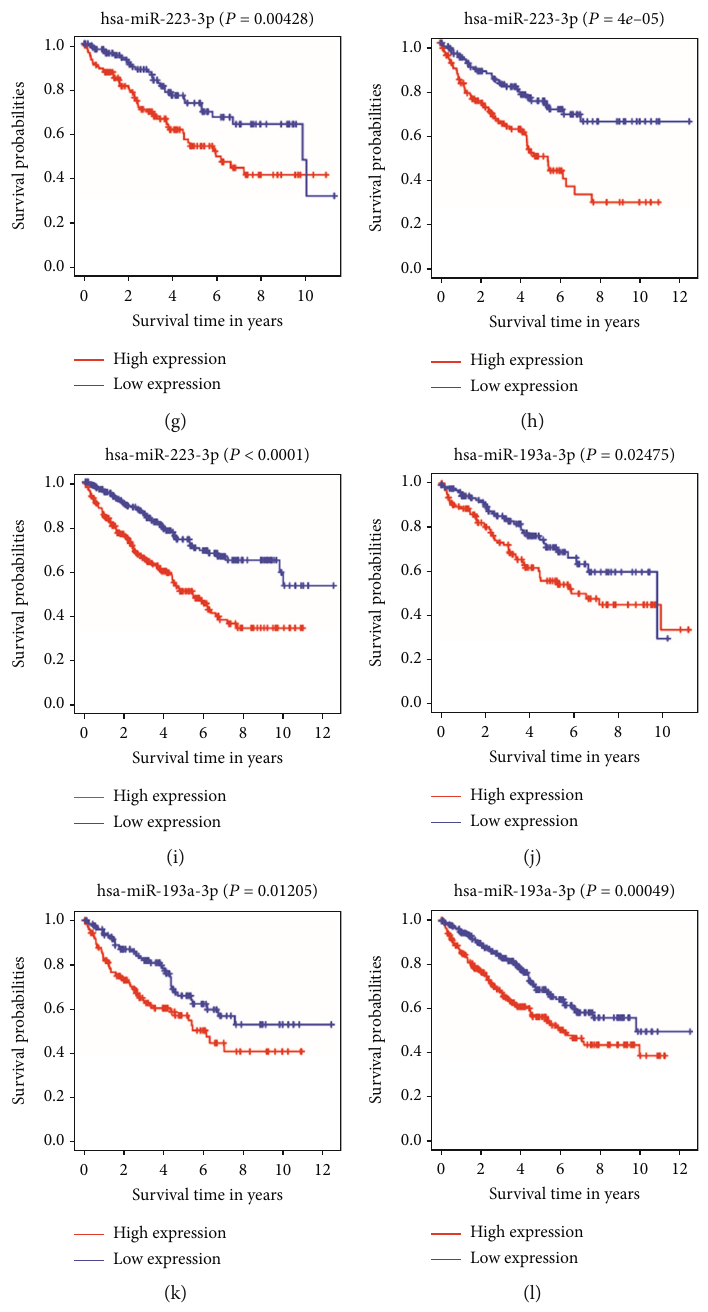
Figure 2: Development of necroptosis-related miRNA (NRM) signature in TCGA training cohort. (a) LASSO Cox regression analysis of the 11 overall survival- (OS-) related NRMs. (b) Plot of 10-fold cross-validation error rates in the LASSO Cox regression analysis. (c) Hazard ratio of the six mRNAs identi fi ed. The principal component analysis (PCA) plot of the distribution between the high- and low-risk groups in (d) the training cohort, (e) the testing cohort, and (f) the whole TGCA cohort. Kaplan-Meier plot of has-miR-223-3p in (g) the training cohort, (h) the testing cohort, and (i) the whole TCGA cohort. Kaplan-Meier plot of has-miR-193-3p in (j) the training cohort, (k) the testing cohort, and (l) the whole TCGA